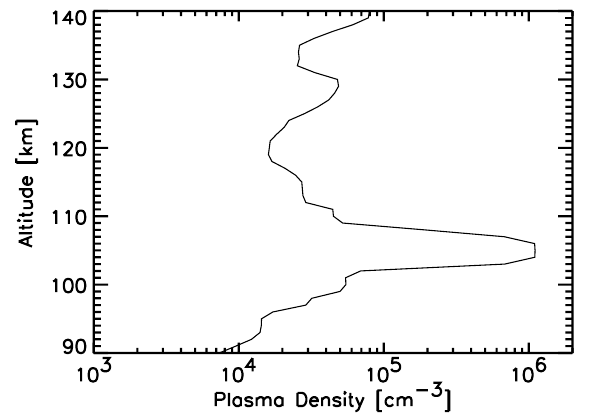
Fig. 7. A profile of the plasma density obtained from the simulation at t = 3600s of Yokoyama et al. (2004b).